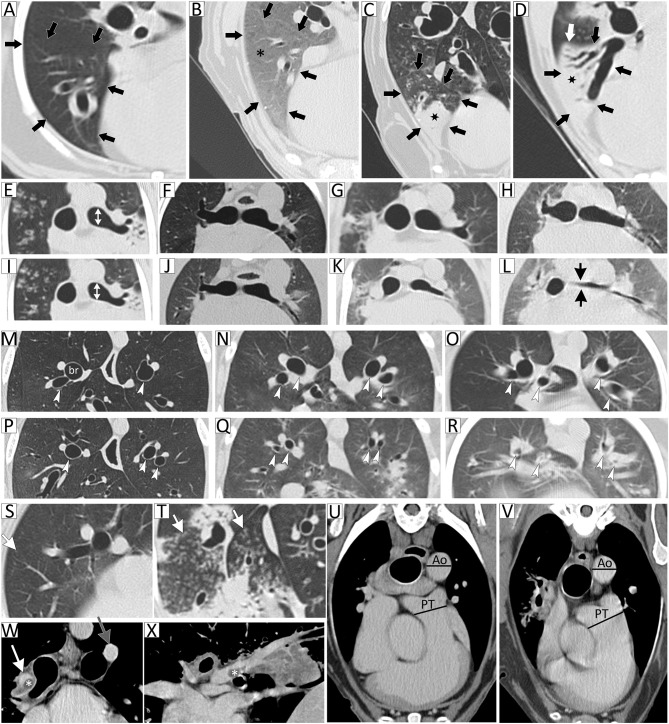
Thoracic computed tomography (CT) disease severity score categorical examples. Lung attenuation category represented by images (A–D) of the right middle lung lobe (outlined by black arrows). (A) Normal parenchymal attenuation, (B) primarily ground-glass opacity (GGO; asterisk), (C) GGO with consolidation (marked by star), and (D) predominant consolidation. In this example, the entire lung lobe is consolidated and the lung margin is visualized (white arrow). Airway caliber changes category, subcategory tracheal or principal bronchi narrowing, is represented by images (E–L). Images are paired inspiratory (E–H) and expiratory (I–L) series. (E,I) are normal with white double-headed arrows indicating diameter of principal bronchus, (F,J) <1/3 diameter reduction of principal bronchial caliber comparing inspiratory to expiratory (I/E) series, (G,K) ≥1/3 to 2/3 diameter reduction of principal bronchial caliber on I/E series, and (H,L) ≥2/3 diameter reduction of principal bronchial caliber on I/E series. Airway caliber changes category, subcategory bronchomalacia, is represented by images (M–R). Images are paired inspiratory (M–O) and expiratory (P–R) series. (M,P) are normal with white arrowheads indicating normal bronchi, (N,Q) highlight the dynamic expiratory distorted circular appearance to bronchi with moderate peribronchovascular opacification (PBVO), and (O,R) represent dynamic near-complete disappearance of airway lumen with marked PBVO on expiration. Airway caliber changes category, subcategory tree-in-bud, is represented by images (S,T), (S) showing occasional tree-in-bud (arrow) and (T) severely affected. Vascular disease category, subcategory pulmonary thromboembolism, is represented by images (W,X), showing an intraluminal filling defect consistent with a thrombus (marked by asterisk) in the right main pulmonary artery and extending into lobar artery on transverse (W) and sagittal (X) views. Vascular disease category, subcategory pulmonary trunk to descending aorta ratio (PT:Ao), is represented by images (U,V), with (U) being normal and (V) with PT:Ao >1.4 suggestive of pulmonary hypertension.